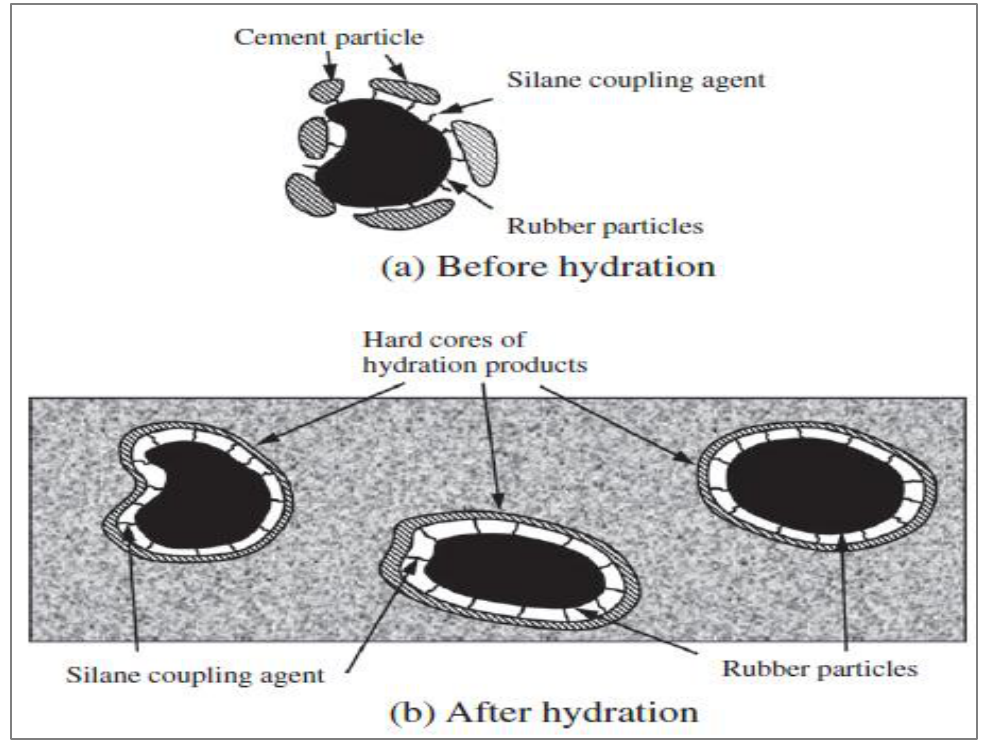
Figure 18. Mechanism of Cement Coating [105]: Used as per Elsevier permissions.